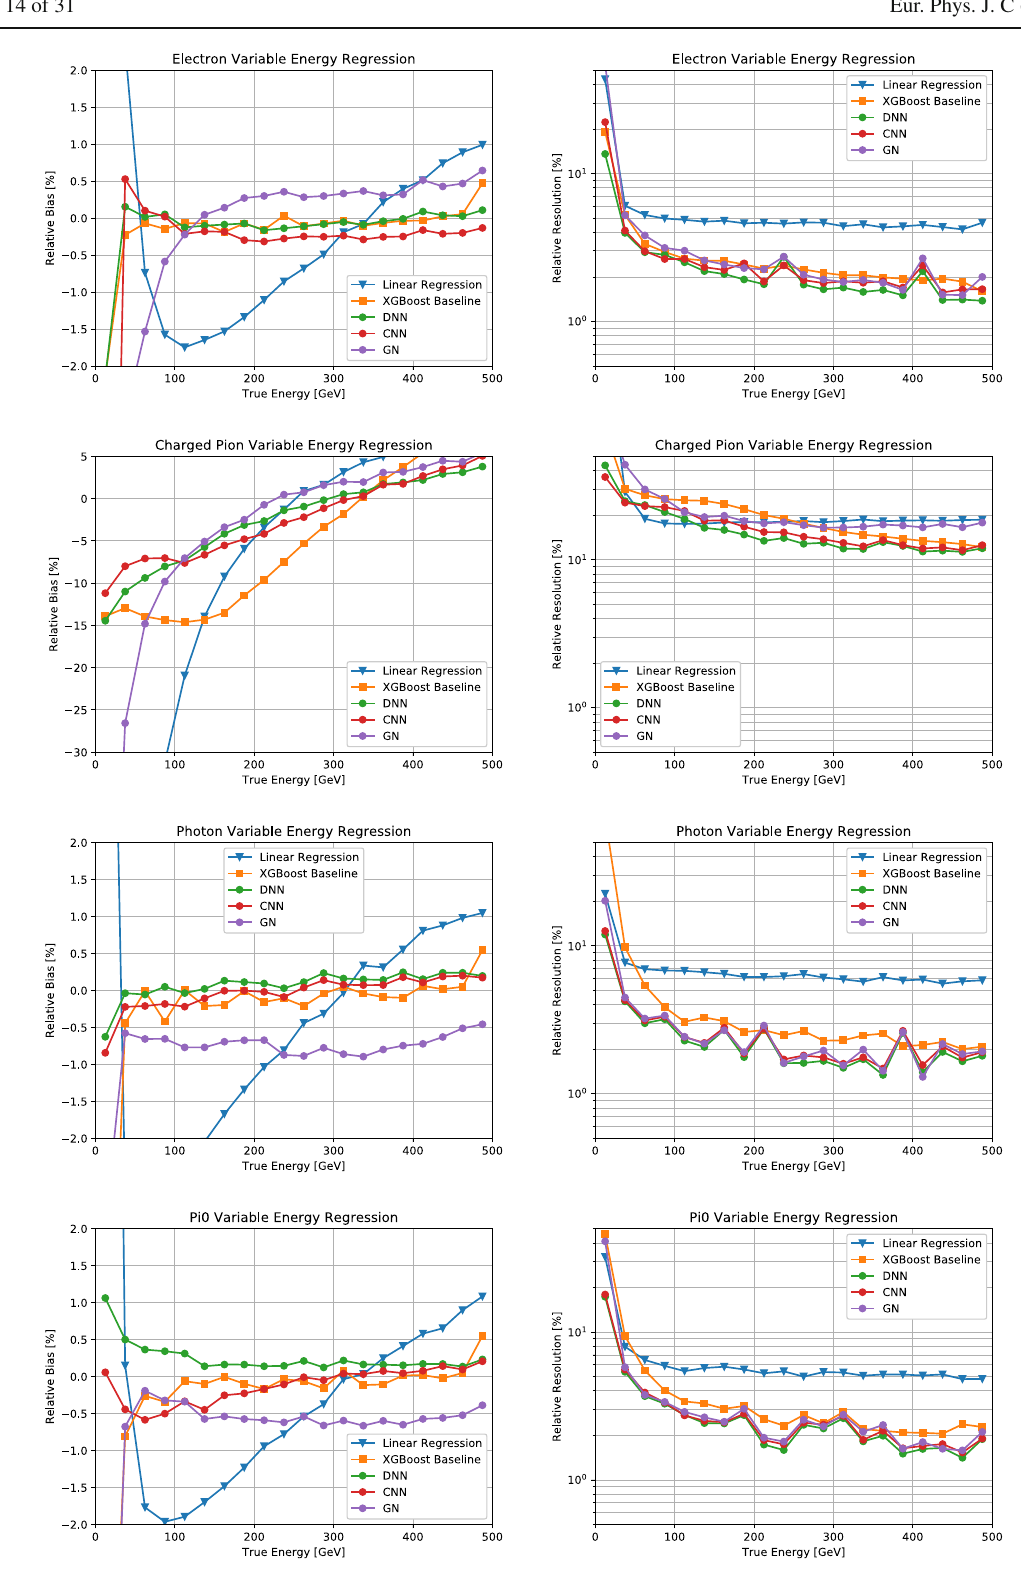
Fig. 15 Regression bias (left) and resolution (right) as a function of true energy for energy predictions on the REC dataset with variable- angle incident angle. From top to bottom: electrons, charged pions,